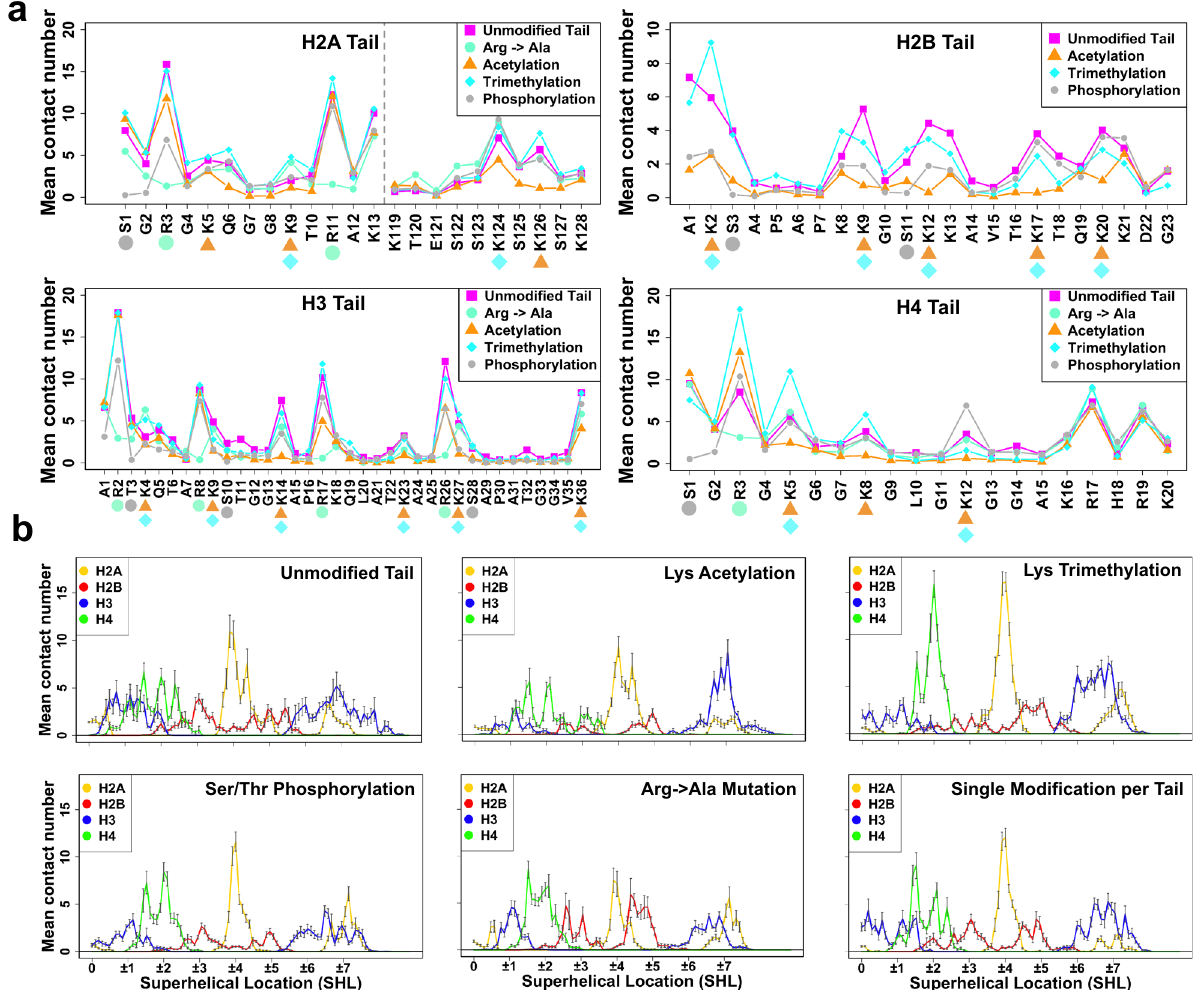
Fig. 5 Histone tail post-translational modi fi cations and mutations modulate histone tail – DNA interaction modes and DNA accessibility. a Mean number of histone tail – DNA contacts for different types of modi fi cations per residue. The result of simulations of model D with and without corresponding modi fi cations are shown in different colors and modi fi cations are shown by a symbol next to the residue. b Mean numbers of nucleosomal and linker DNA contacts with histone tails for different types of modi fi cations per DNA base pair. For each type of modi fi cation, the reported values are averaged, and the error bars represent the standard errors of the mean calculated from independent simulation runs for two copies ( n = 10). The locations and types of modi fi cations and mutations are listed in Supplementary Table 2. The mean number of contacts of unmodi fi ed tails was calculated using the fi rst 1600 ns frames from the trajectory of the simulation of Model D with the AMBER package (Supplementary Table 1). Source data are provided as a Source Data fi